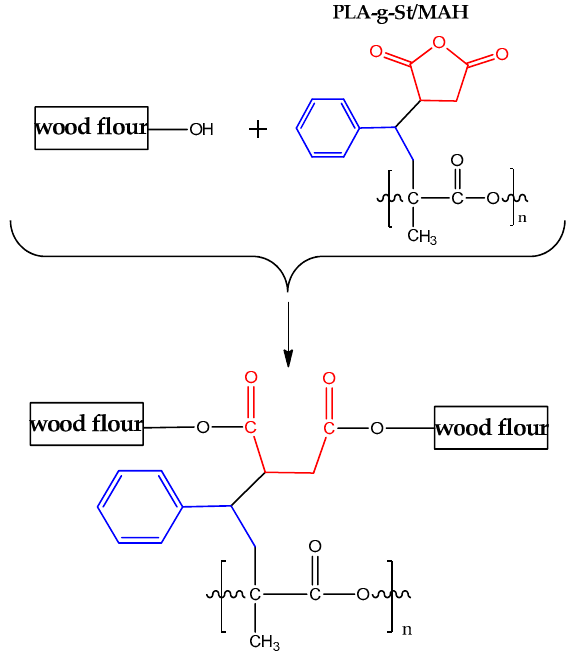
Figure 6. Possible reaction mechanism of wood flour/PLA composites in the presence of PLA- g